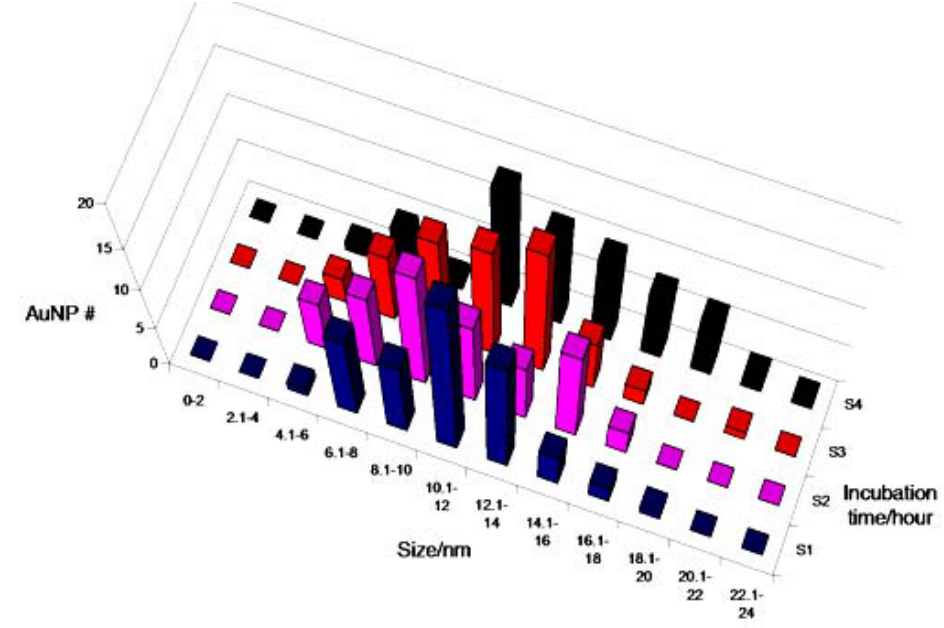
Figure 6. Histogram of NP size distributions of control samples in TE buffer without plasmid DNA incubated for 1 h (S1, blue), 2 h (S2, purple), 4 h (S3, red), and 7 h (S4, black). Despite the high level of aggregation, the particles were still counted individually. The level of particle aggregation was greatest in the 7 h sample (Figure 3). No correlation between the NP size and the incubation time was observed.